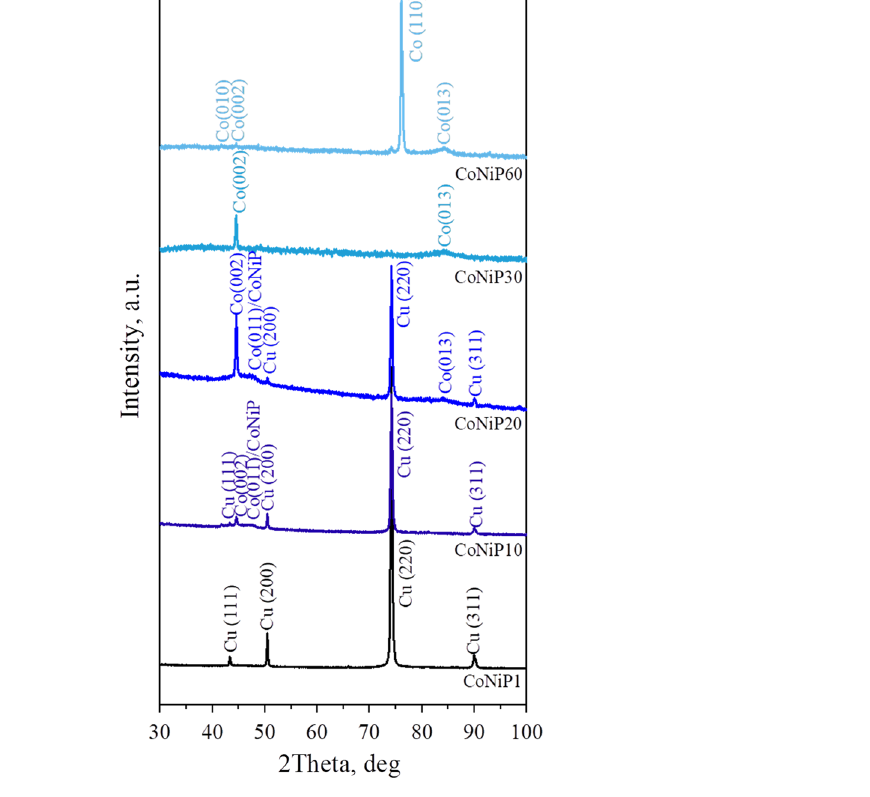
During deposition, agglomerates are formed on the surface of the coating. At the initial deposition time, irregularly shaped agglomerates predominate over the entire surface of the coating (Fig. 2b). The size of these formations varies from 2.6 to 4.4 µm. Most agglomerates have a diameter of 3.2–3.8 µm. The morphology of the particles obtained with a longer deposition time is also shown in Fig. 2. As the deposition time increases, the shape of the particles gradually improves. The particles on the surface of the CoNiP20 and CoNiP30 samples are smooth agglomerates of a spherical shape. It is also observed that the number of separately located agglom- erates on the sample surfaces is small. On most of the sample surfaces, the particles form chains or islands of agglomerates. With rising time, the number of particles on the sample surfaces increases, and after 60 min of deposition, the agglomerates coalesce with each other and form a new coating layer. The size of these particles changes slightly with increasing time. All spherical sediments are similar in diameter. Their diameter is 9–11 µm and does not depend on the change in deposition time. The number of agglomerates with a diameter of less than 9 or more than 11 µm is insignificant. The content of Co, Ni, and P in CoNiP coatings was measured by energy dispersion analysis X-ray spectros- copy. Figure 3 shows the dependence of the coating composition on the electrodeposition time. Three areas can be distinguished on the graph. In the first area, a high content of nickel and phosphorus is observed, which decreases with increasing deposition time. In the second area, on the contrary, there is an increase in the nickel content and a decrease in the cobalt content. The phosphorus content increases slightly. In the third area, a significant increase in the cobalt content is observed, and the nickel and phosphorus contents decrease. Figure 4b demonstrates a SEM image of the CoNiP20 sample`s end face. It can be seen that some of the formations in the scales form are located under the agglomerates. Agglomer- ates begin to form on these formations. The composition of individual sections of the CoNiP20 coating surface was also considered. As can be seen from Fig. 4, the smooth coating and agglomerates have a completely differ- ent composition. The coating has a high content of nickel and phosphorus, while the agglomerates have a high content of cobalt. When studying the side view of the surface, it was revealed that the scale formations contain a large amount of phosphorus and oxygen. A thin coating of NiCoP alloy with a relatively high phosphorus content is formed on the surface in one min- ute of deposition. At the moment, active centers are beginning to form on the surface of the thin NiCoP coating. During working time, the electrolyte degrades and phosphorus-containing complexes diffuse and adsorb onto the coating surface. This confirms the composition of the scale formations (Fig. 4).